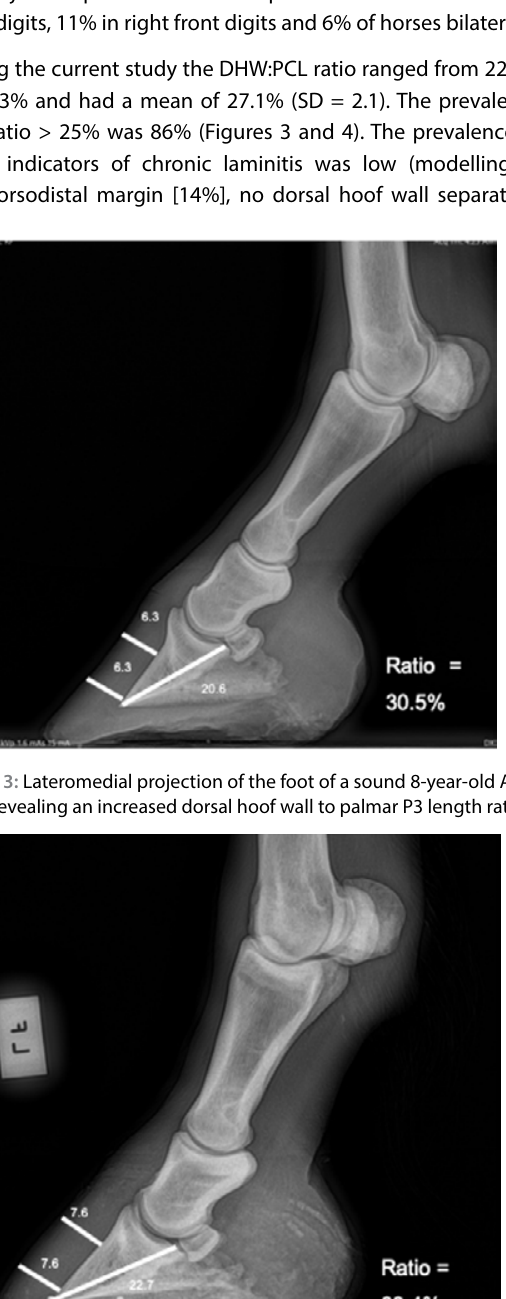
Figure 2: Lateromedial projection of the foot revealing dorsopalmar hoof imbalance in a 16-year-old Arab gelding. Note the heel and dorsal hoof wall angles are not equal, nor does the vertical line from the centre of the condyles of P2 bisect the solar surface. There is moderate ossification of one or both ungular